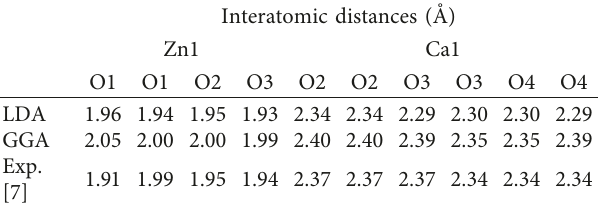
Table 3: Interatomic distances in ZnO